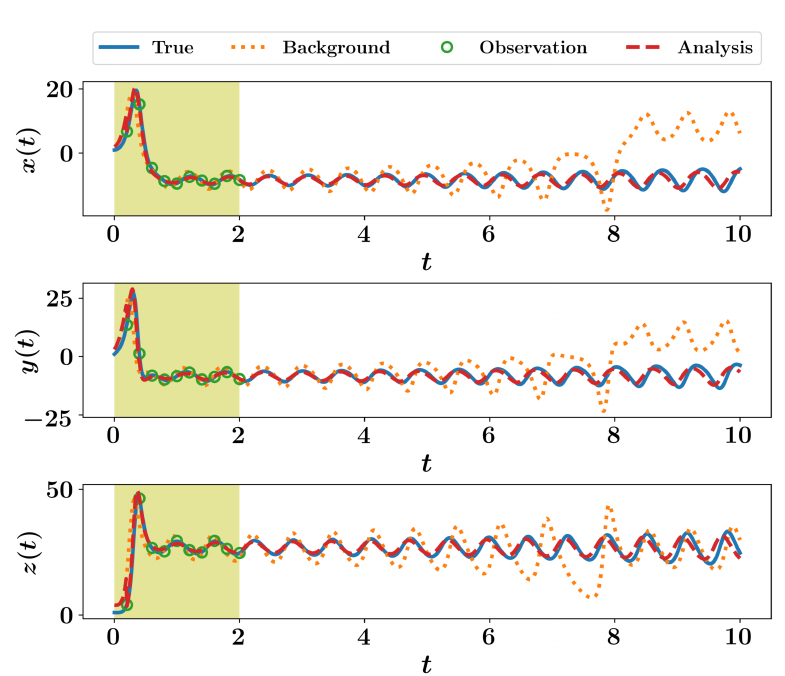
Figure 4. EKF results for the Lorenz 63 system with the assumption of zero process